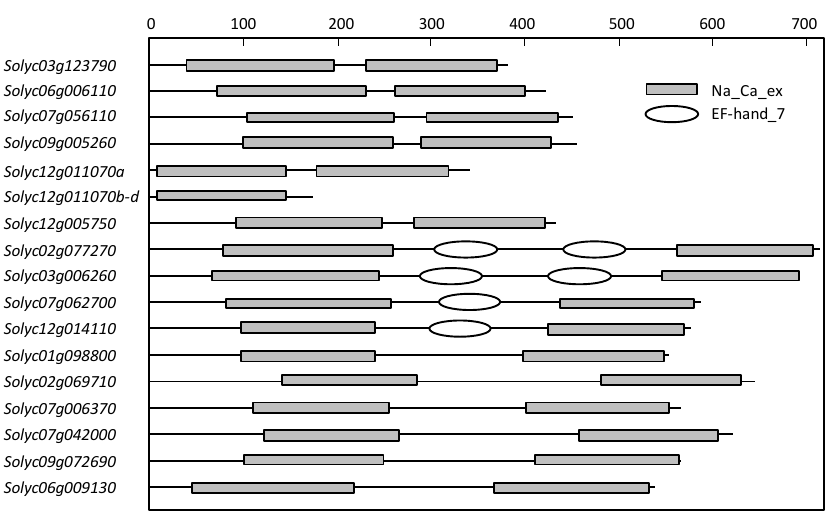
Figure 2. Domain architecture of tomato CaCA ( SlCaCA ) proteins. Gray rectangles and white ovals represent Na_Ca_ex and EF-hand domains, respectively.